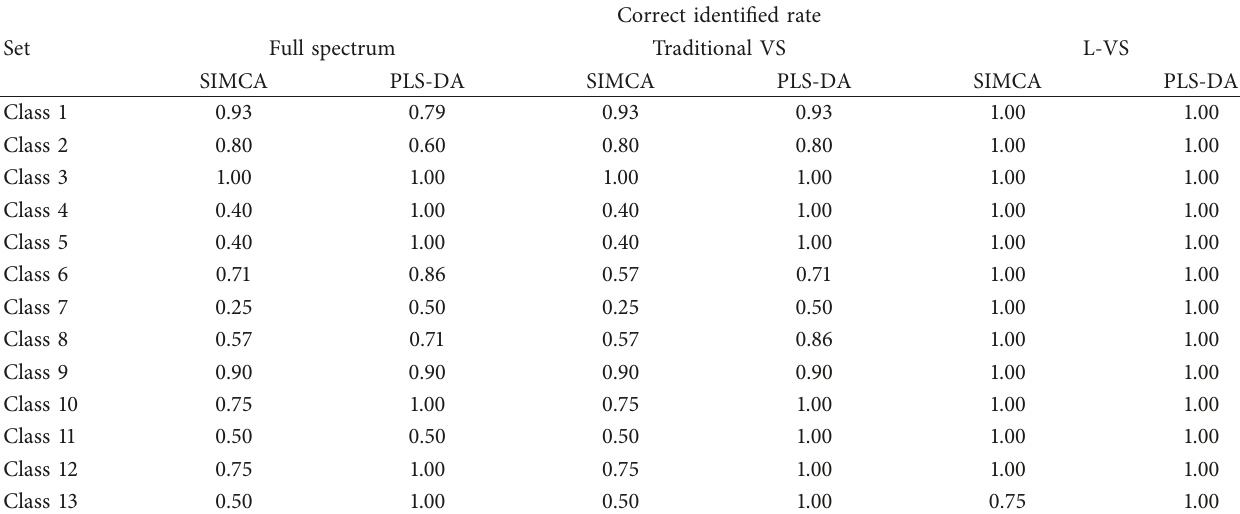
Table 3: Comparison of classification rates between different